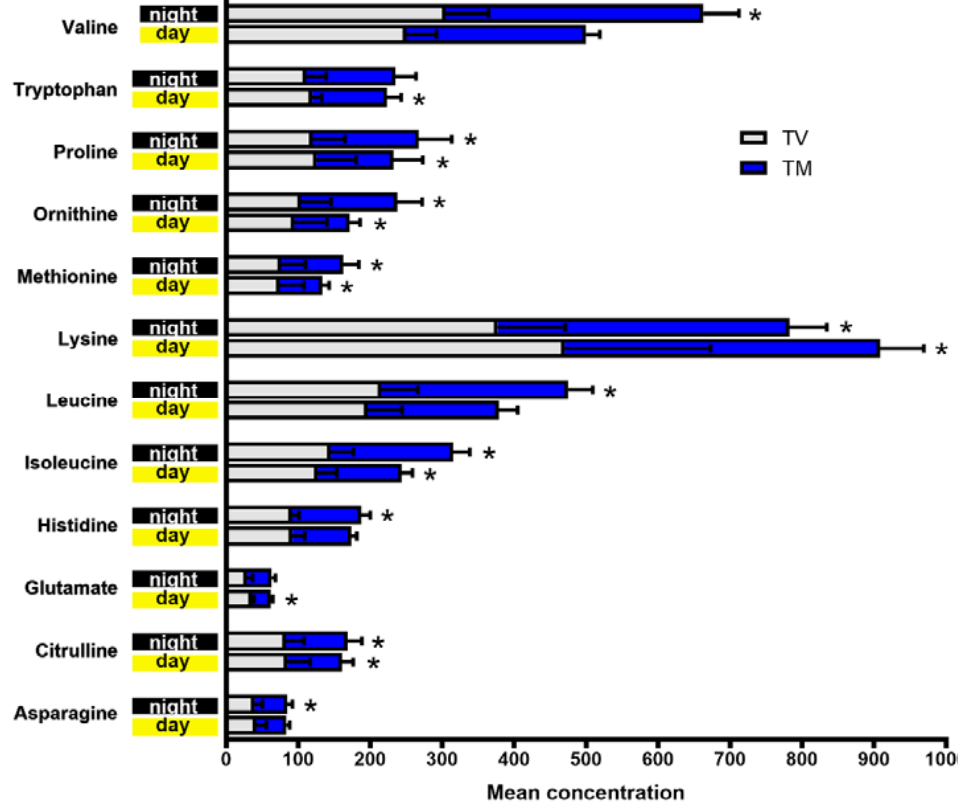
Figure 3. Changes in amino acid levels after melatonin treatment. Evaluation of 12 metabolites measured throughout the day and night in BC-bearing mice. TM: tumor treated with melatonin “blue horizontal bar”; TV: tumor treated with vehicle “soft grey horizontal bar”. Student’s t -test. * p < 0.05.